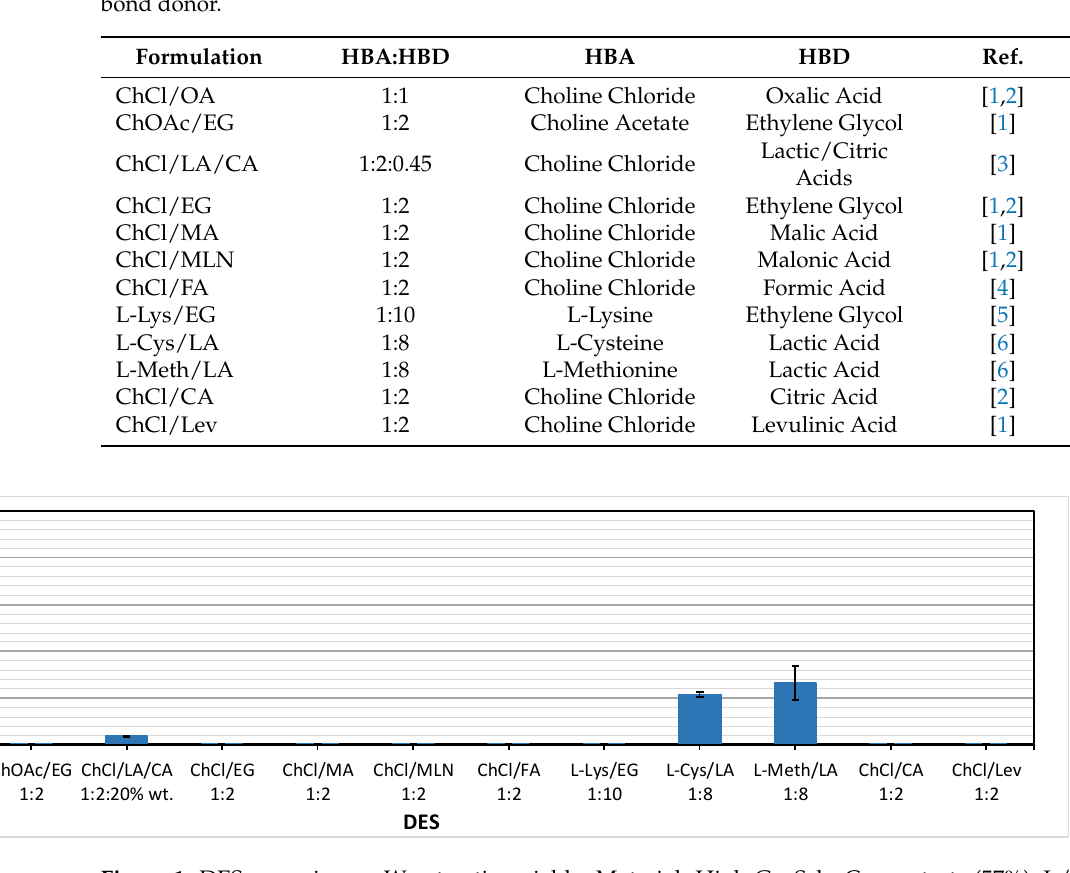
Figure 1. DES screening on W extraction yields. Material: High-Gr. Sch. Concentrate (57%), L/S Ratio 10, T 80 °C, time 24 h.